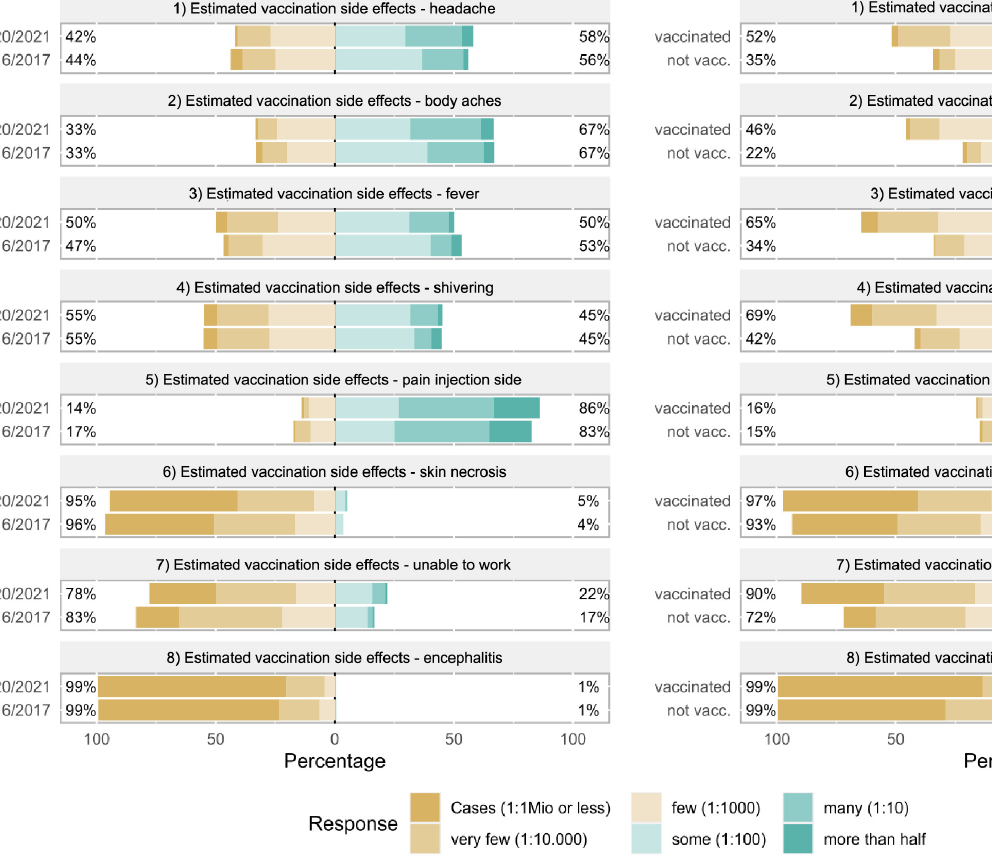
Fig 3. Comparison of estimated frequencies of influenza vaccination side effects between 2016/2017 and 2020/2021 or between vaccinated and unvaccinated respondents in 2020/2021. Estimated frequency of side effects associated with influenza vaccination assessed on a 6-Point Likert scale was compared between the seasons 2016/2017 and 2020/2021 (left) or between vaccinated and not vaccinated respondents in 2020/2021 (right). Statistics were performed after conversion of ordinal answer levels to a numeric scale using Mann-Whitney U tests, p-values are depicted as � < 0.05, �� < 0.01 and ��� < 0.001.